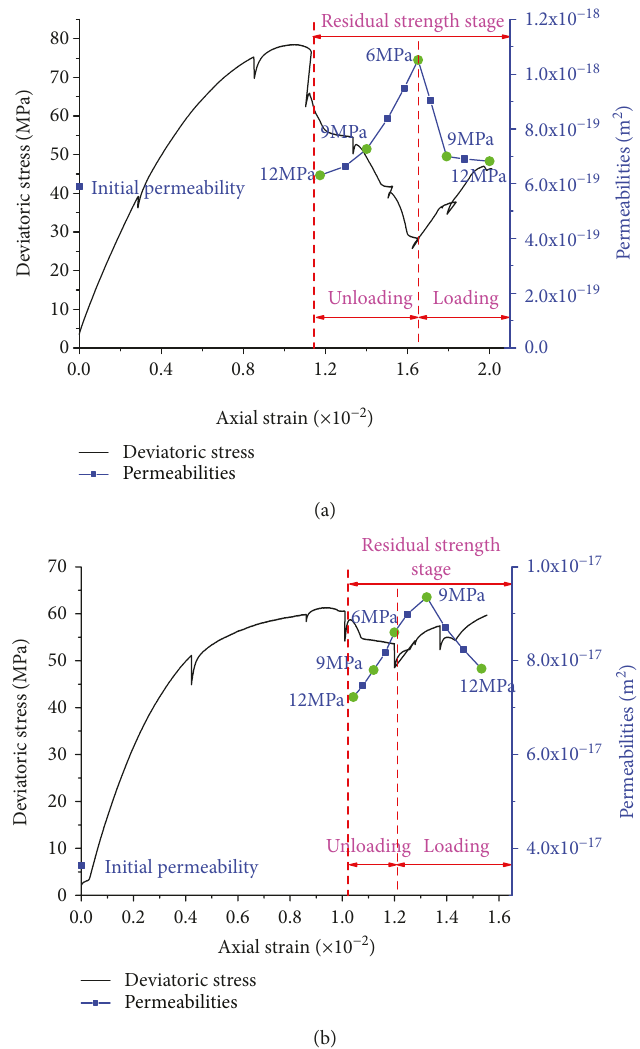
Figure 3: Variations in the permeability of weakly cemented rock during the process of postpeak loading and unloading. Table 3: Summary of the permeabilities of rocks in di ff erent stages during the process of postpeak loading and unloading. Lithology k 0 (m 2 ) k 1 (m 2 ) k 2 (m 2 ) Mudstone Shaly coarse